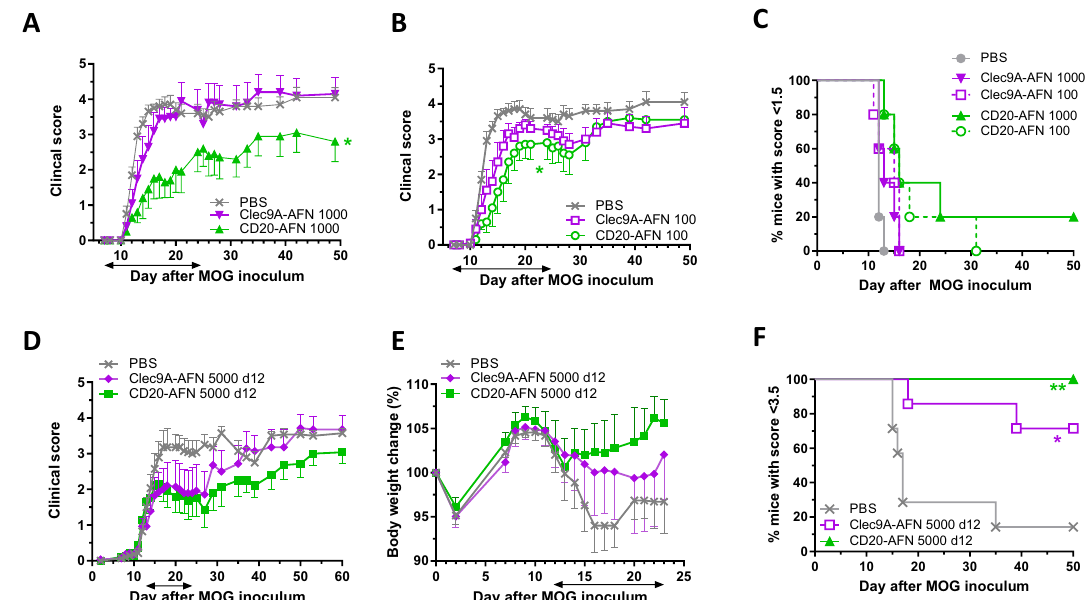
Figure 2. CD20-AFN protects better than Clec9A-AFN at lower doses, and in a therapeutic setting. Shown are clinical scores ( A , B , D ), % of diseased mice ( C ), body weight ( E ), or % of severely paralyzed mice ( F ). ( A – C ) Mice were treated with 1000 or 100 IU AFNs starting d7, ( D – F ) mice were treated with 5000 IU AFNs from d12 on. Shown are representative experiments (n = 5–7). The black horizontal arrow indicates the treatment period. Differences were assessed using two-way ANOVA followed by Dunnett’s multiple-comparison test ( A , B , D , E ), or using Chi Square Log-Rank test for the Kaplan–Meier plots ( C , F ); *P < 0.05, **P < 0.01, compared with PBS treated animals.